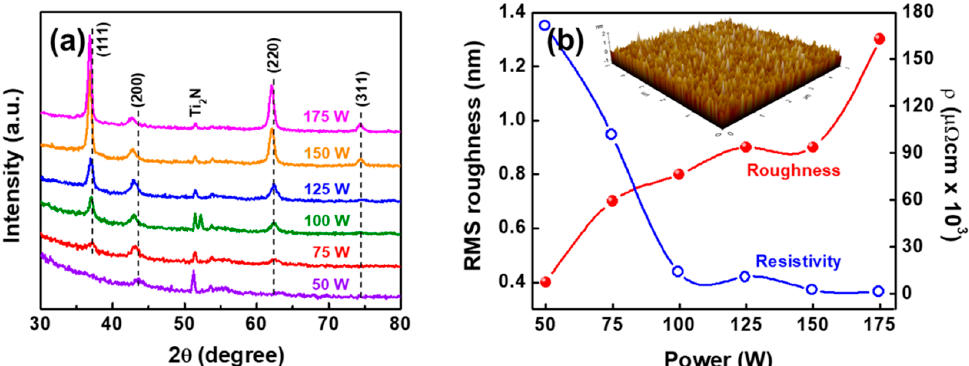
Figure 3. ( a ) XRD patters, ( b ) RMS roughness (R q ) and resistivity of TiN thin film on the Si/SiO 2 <100> substrate with various source power.